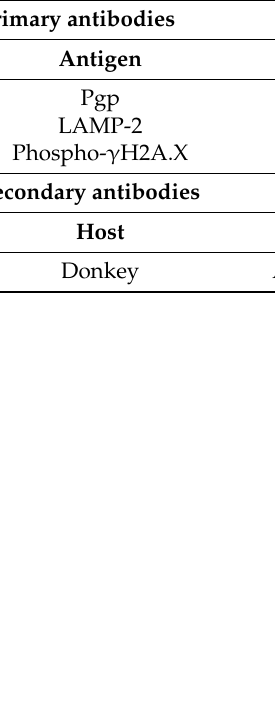
Table 6. Primary and secondary antibodies used for indirect immunofluorescence